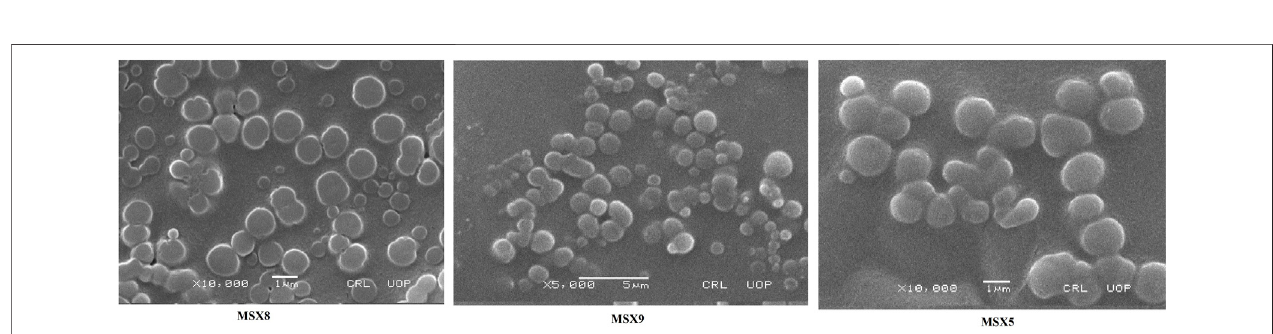
FIGURE 6 | SEM images of methotrexate loaded nanoparticles prepared using Eudragit S100.